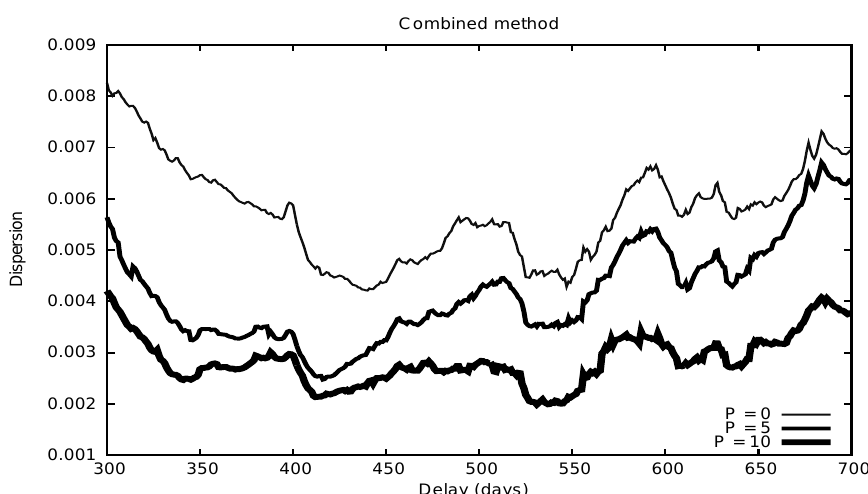
Fig. 3. Combined dispersion spectra for three different polynomial degrees. Vander- riest et al. (1989) data. See Table 2 for delay estimates for different P